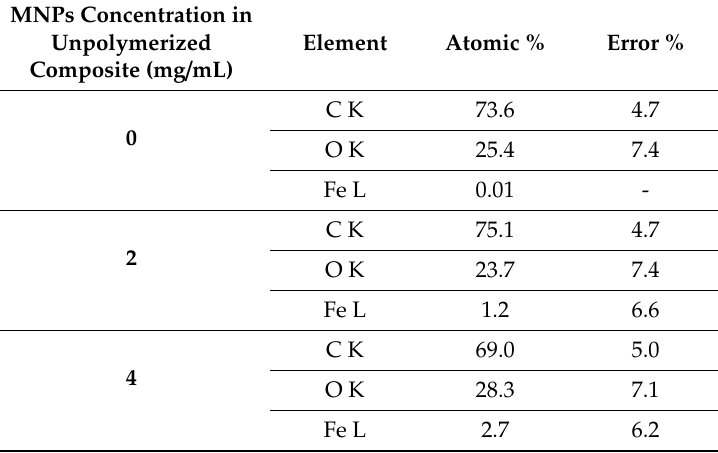
Table 2. Elemental composition of the polymerized Ormocore / MNPs composites as determined by